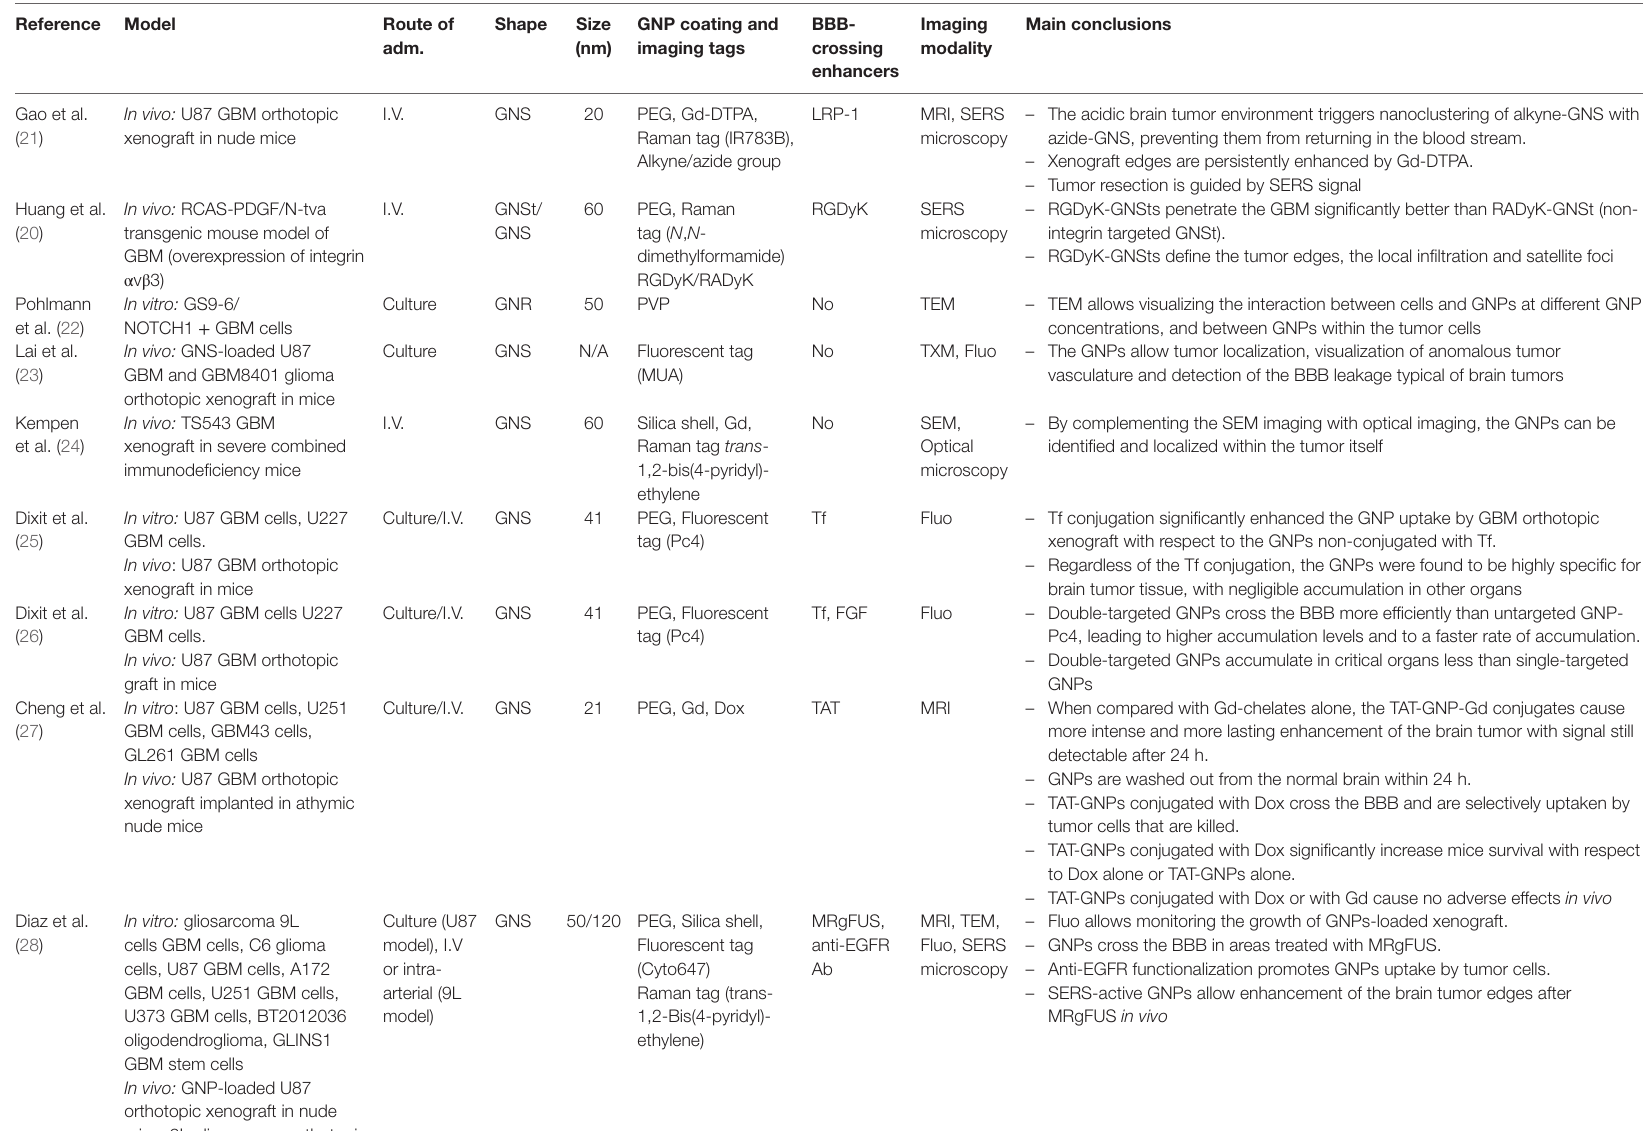
taBLe 1 | Overview of the included